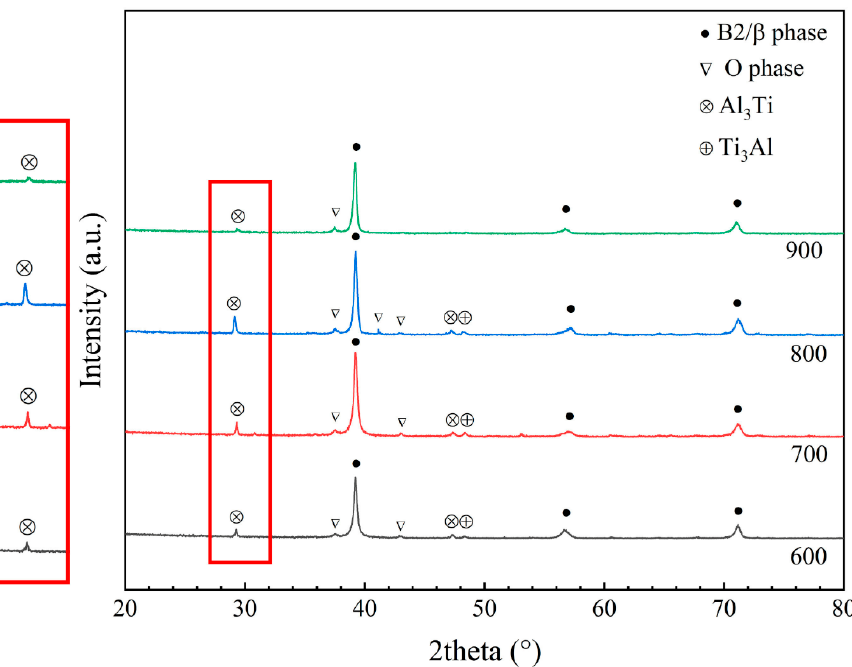
Figure 9. XRD patterns of the Ti-22Al-25Nb alloy with different scanning strategies via SLM process. The XRD patterns in Figure 9 verify the presence of some secondary phases (e.g., O phase and Ti-Al intermediate phases). To further verify the distribution of the above phases, the O (red in color) phase and Ti-Al phases (blue in color) were deducted from the EBSD orientation maps (Figure 10a,c,e,g). We used ellipses of corresponding color to mark the enriched area of the phases. As depicted in Figure 10b,f,d,h, the secondary phases were distributed more uniformly in the single grains at a lower scanning speed, labeled by the red arrow. By contrast, the secondary phases were primarily distributed in the region with a high strain concentration near the pool boundaries. Notably, in S4, the secondary phases were concentrated in the pool boundaries (Figure 10h).